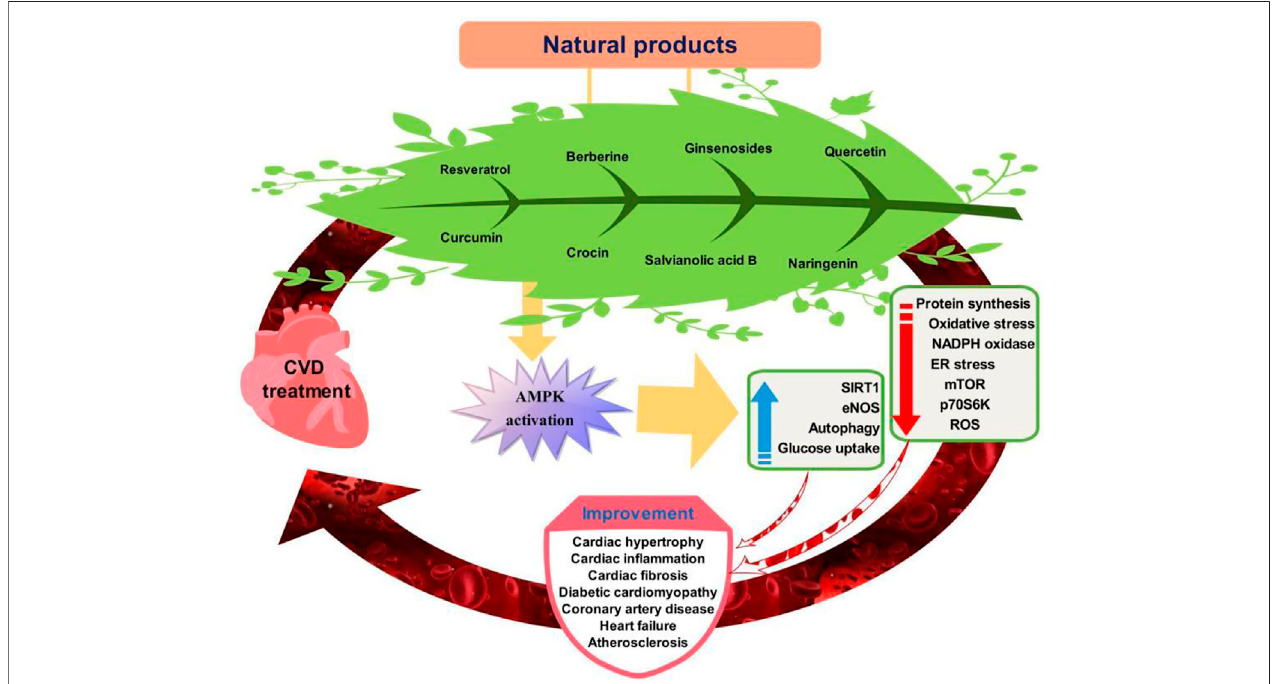
FIGURE 2 | Targeting of AMPK signaling pathway by natural products for cardiovascular disease